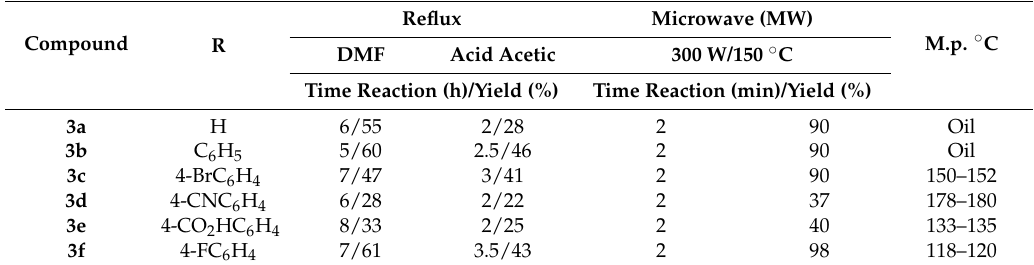
Table 1. Comparative study of conventional vs. microwave